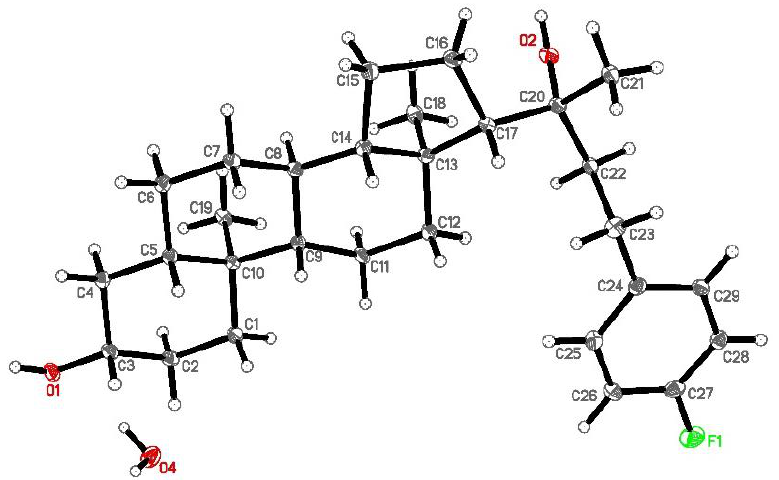
Figure 2. Ortep representation of Oxy186 in the solid state.